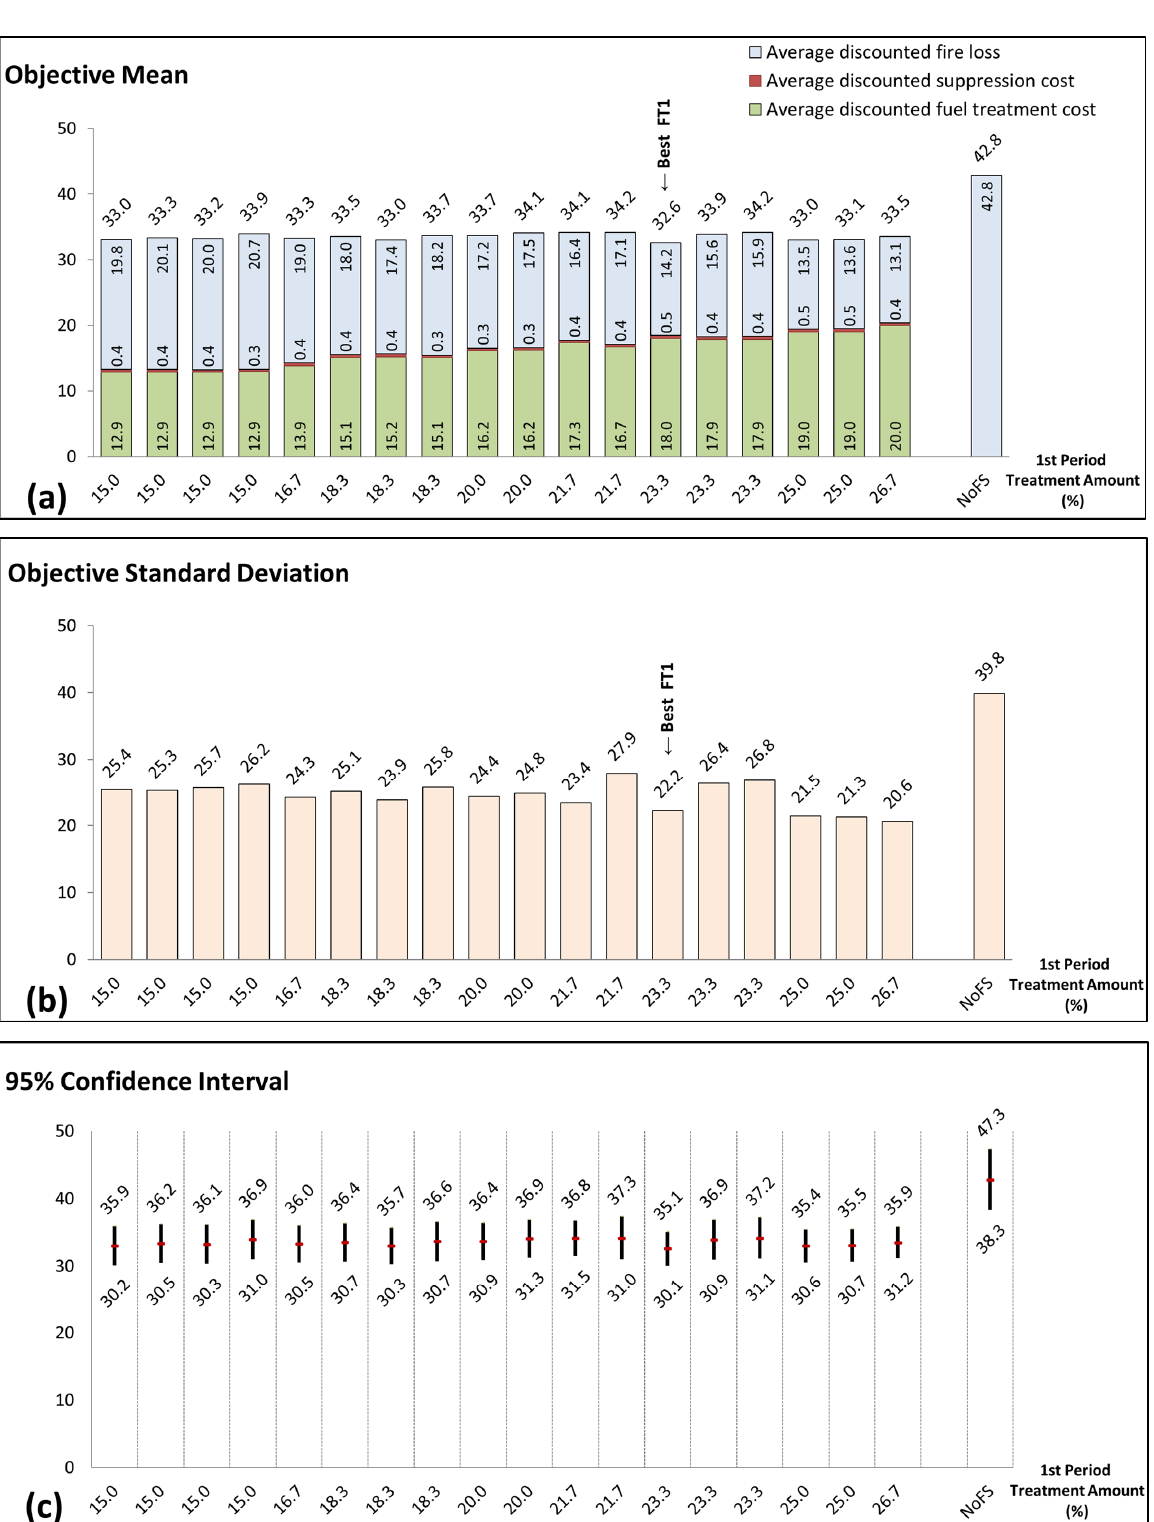
Figure 8. The best and the alternative FT1s under the assumption of low FPV. Results include: ( a ) objective function value means; ( b ) objective function value standard deviations; ( c ) 95% confidence intervals of the means.